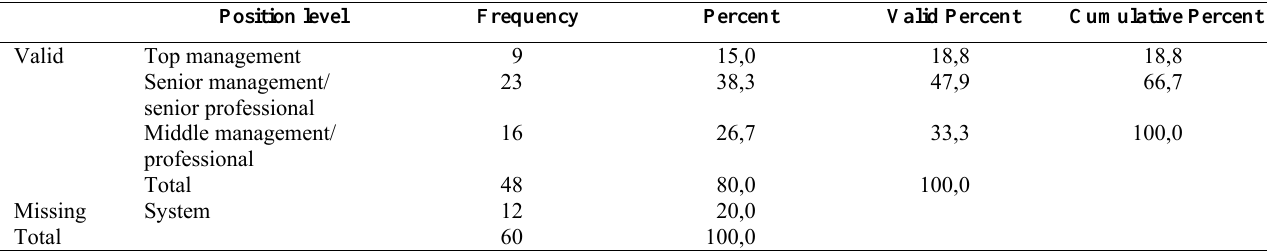
Table 3: Distribution of unit leader position level